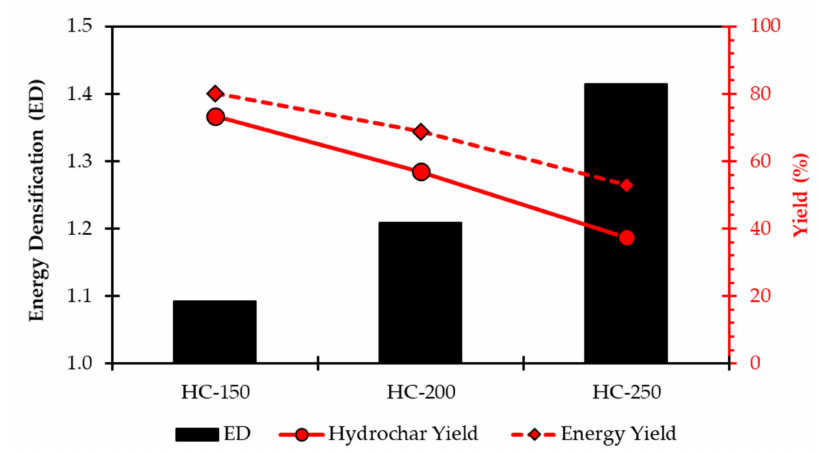
Figure 1. Energy densification, hydrochar yield and energy yield of